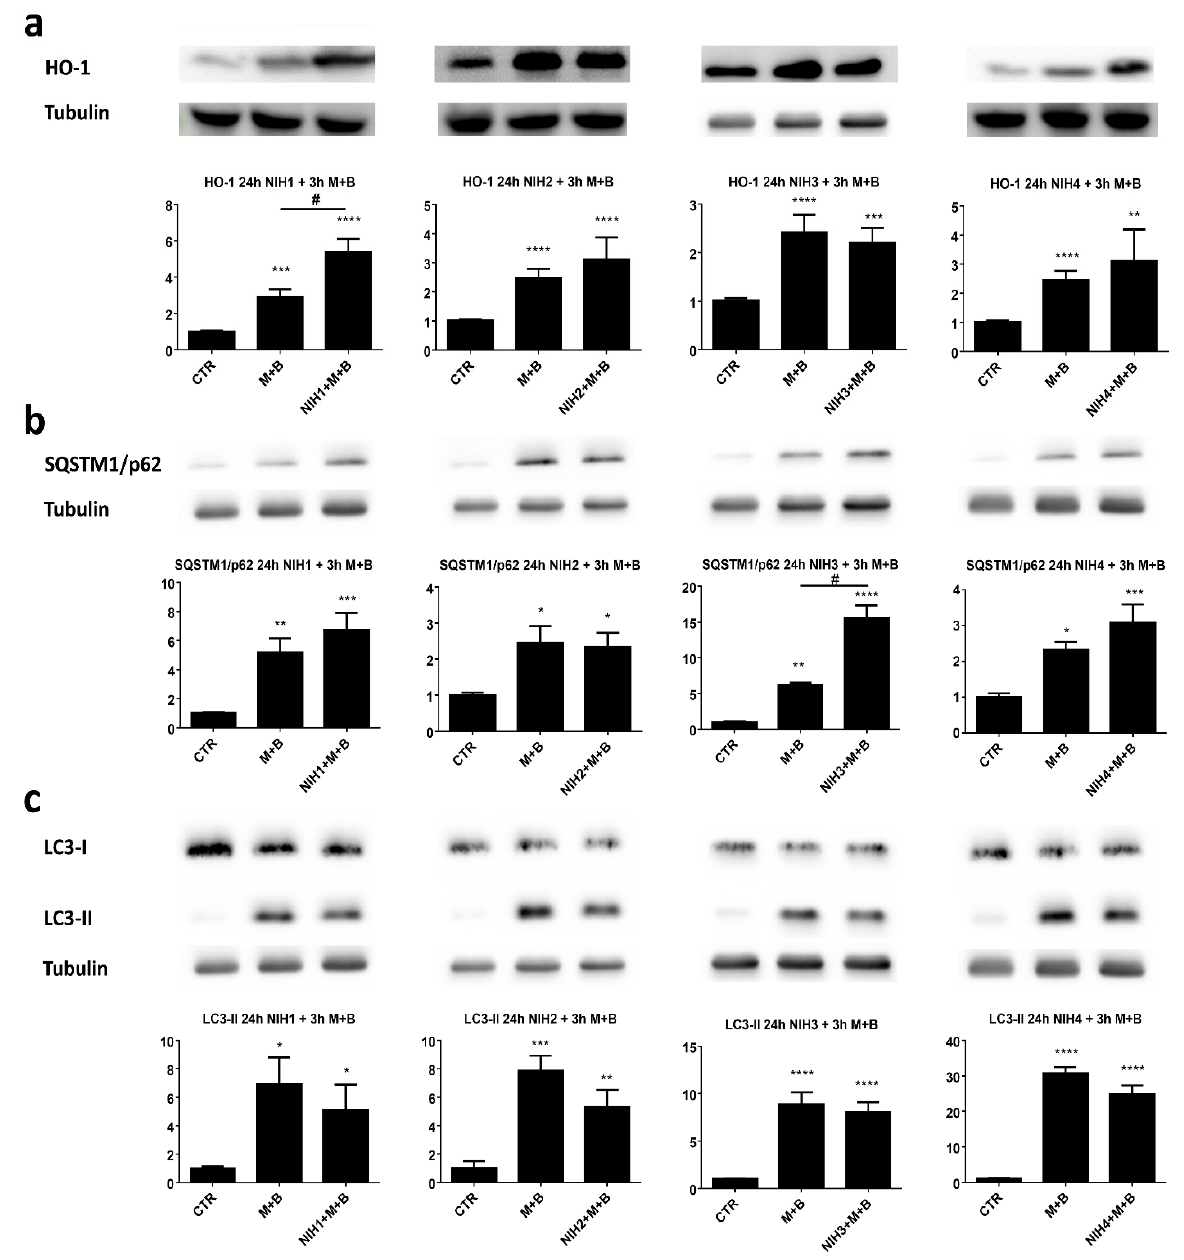
Figure 5. The effect of NIH compounds on the antioxidant defense system and autophagy upon inhibition of protein degradation systems. ARPE-19 cells were pretreated with NIH compounds for 24 h before addition of proteasome inhibitor MG-132 (M, 5 µM) and lysosome acidification inhibitor bafilomycin A1 (B, 50 nM) for 3 h. The protein levels of ( a ) HO-1, ( b ) SQSTM1/p62 and ( c ) LC3-II were analyzed via Western blotting. The protein bands were quantified and normalized against α -tubulin. The results are expressed as fold change of the means compared to control (CTR) ± S.E.M. n = 6, * p < 0.05, ** p < 0.01, *** p < 0.001, **** p < 0.0001, # = statistically significant difference between MG-132 + bafilomycin A1 (M + B) and M + B + NIH3 compound (NIH3 + M + B). Dunn’s multiple comparisons test for HO-1 and Dunnett’s multiple comparisons test—for SQSTM1/p62 and LC3-II, respectively—were used.